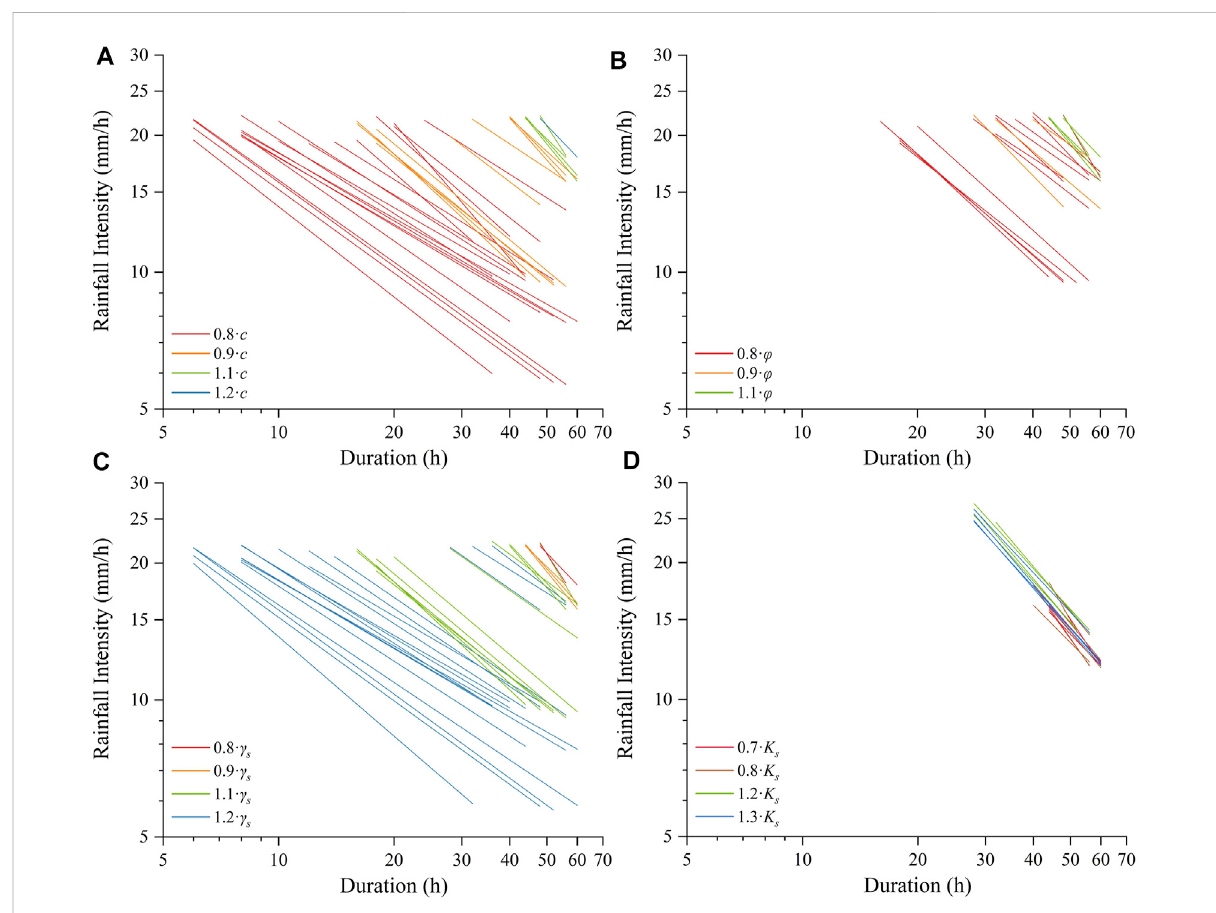
FIGURE 11 I-D thresholds de fi ned at the grid cell scale under differentsoil mechanical and hydraulic parameters: (A) c , (B) φ (the thresholds were the same under the condition of 1.1 · φ and 1.2 · φ ), (C) γ s , and (D) K s